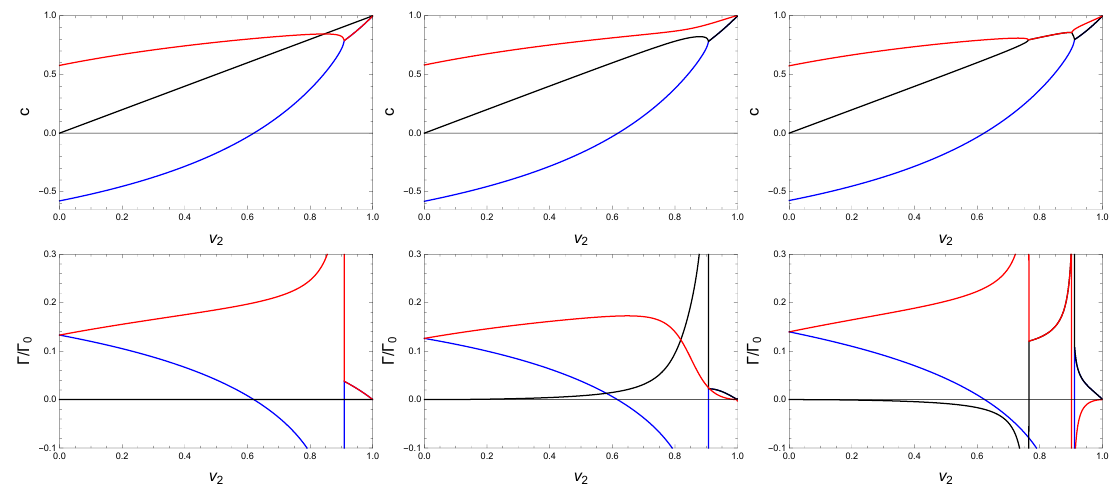
Figure 4. Real parts of speeds ( upper panels ) and attenuation ( lower panels ) of three modes in a coupled two-fluid system in which the chemical potential of the dissipative fluid is clamped, δµ 1 = 0. There is a fourth, purely diffusive, mode, which is not shown here. The entrainment coupling between the fluids is zero ( left panels ), negative ( middle panels ), and positive ( right panels ). The ( black ) mode which only propagates in the presence of a nonzero relative velocity v 2 is dynamically unstable ( Γ < 0) for arbitrarily small v 2 if the entrainment coupling is